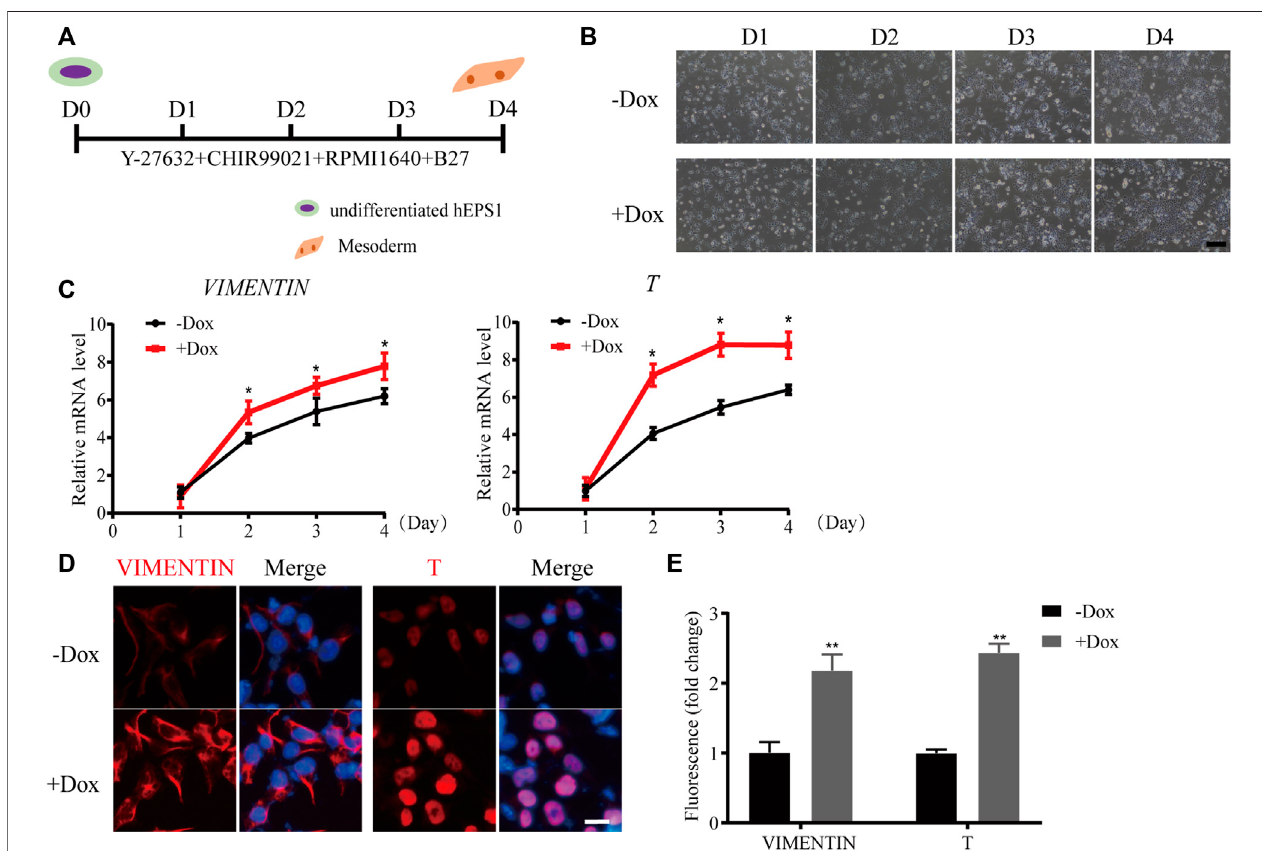
FIGURE4| WDR36knockdownpromotedmesodermaldifferentiationpotentialofhEPS1cellsinamesodermal-committeddifferentiationassay. (A) Timescheme of the mesodermal-committed differentiation assay. (B) Representative images of Dox-induced shWDR36 hEPS1 cells in mesoderm differentiation medium with or withoutDox.Bar=200 μ m. (C,D) mRNA (C) andproteinexpression (D) ofTandvimentininsh1-hEPS1cellstreatedwithorwithoutDox.Bar=50 μ m. (E) Quanti fi cation intensity levels for immuno fl uorescence of T and vimentin in sh1-hEPS1 cells treated with or without Dox. n = 3 experiments; mean ± S. D; two-tailed Student ’ s t -test. *, 0.01 < p < 0.05; **, p < 0.01; no labeling indicates no statistical signi fi